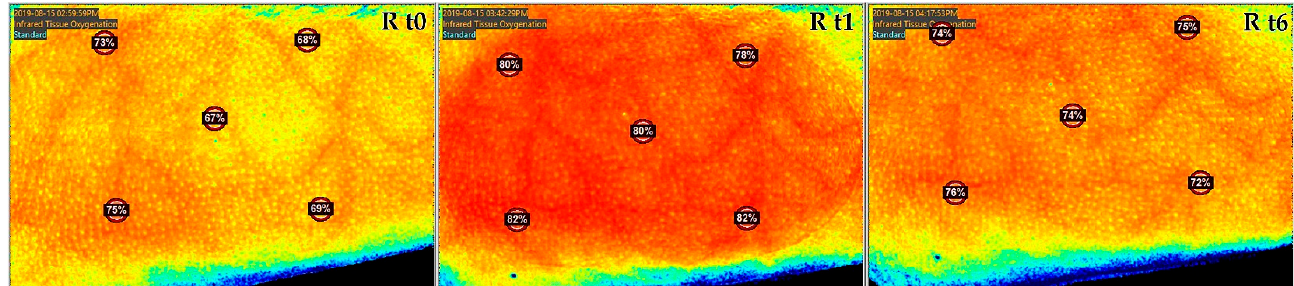
Figure 4. Differences of the means in the oxygen saturation percentage compared to t0 at t1 and t6 measured by near-infrared spectroscopy.